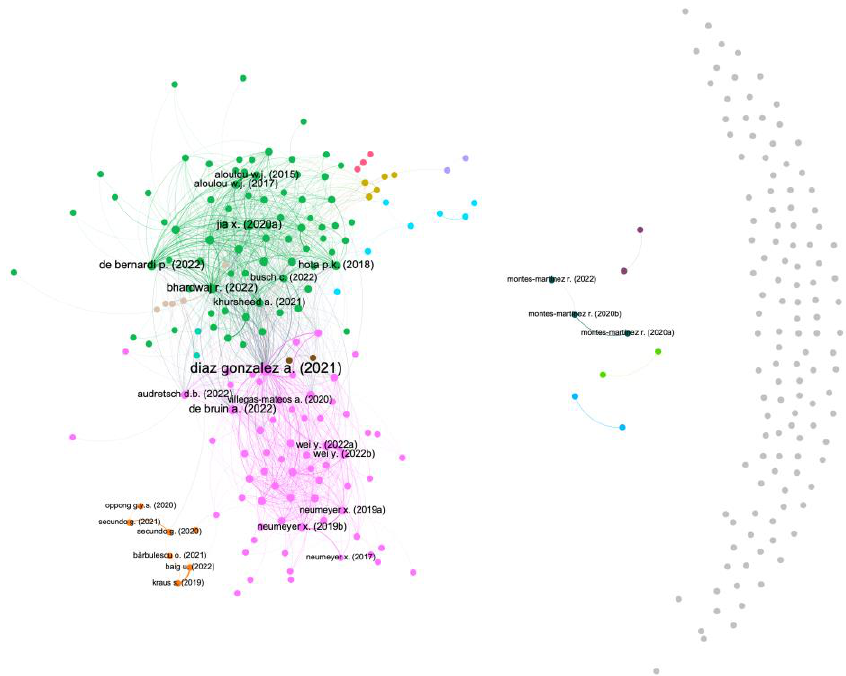
Figure 6. Bibliographic coupling network. Nodes represent articles and the size of the node the de- gree centrality. Links indicate the number of shared references. All links weighing less than 4 articles were cut off. Source: authors based on VOSviewer version 1.6.19 and Gephi version 0.10.1 software.